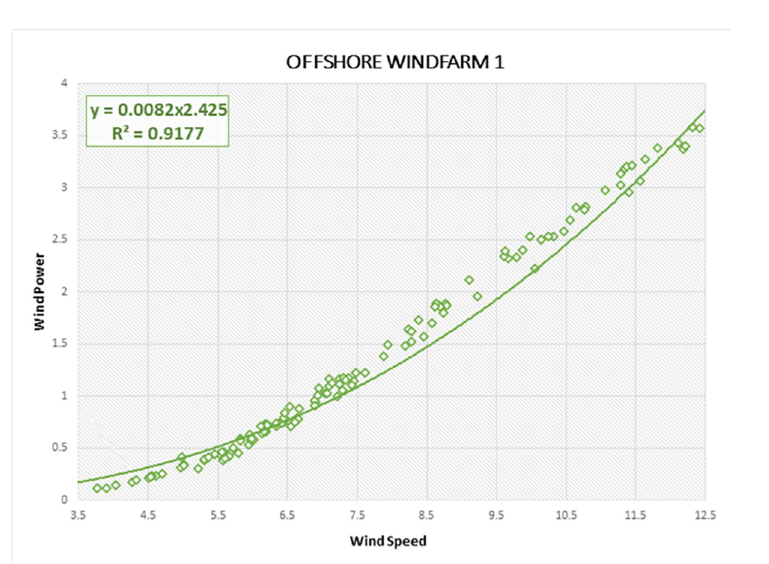
Fig 12. R-Squared correlation and best curve fitting on wind power and wind speed observations of Offshore Windfarm 1 dataset.